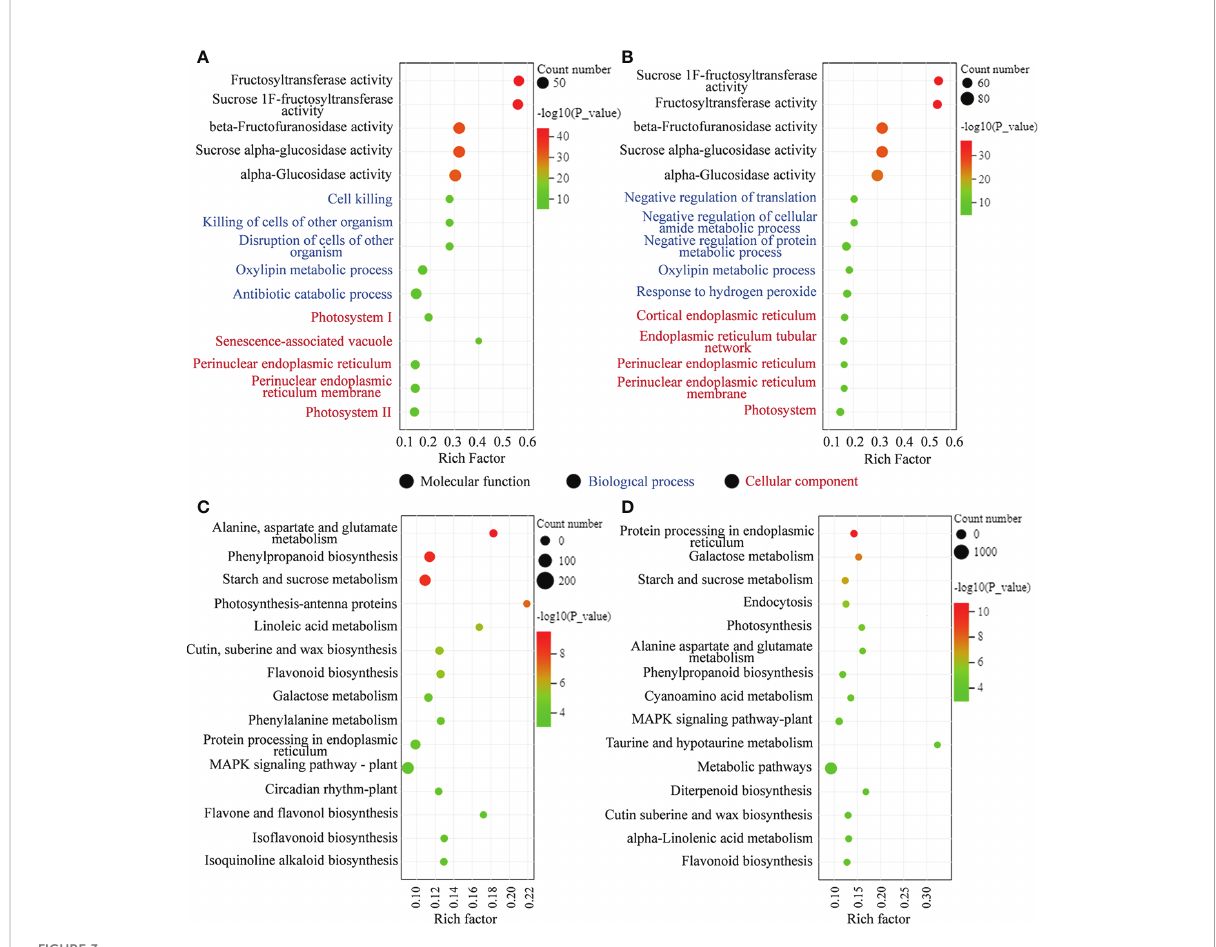
FIGURE 3 DEGs enriched on different GO terms and KEGG pathways. (A) GO terms of DEGs in “ CK vs. D. ” (B) GO terms of DEGs in “ D vs. MD. ” (C) KEGG pathway analysis of DEGs in “ CK vs. D. ” (D) KEGG pathway analysis of DEGs in “ D vs. MD. ”